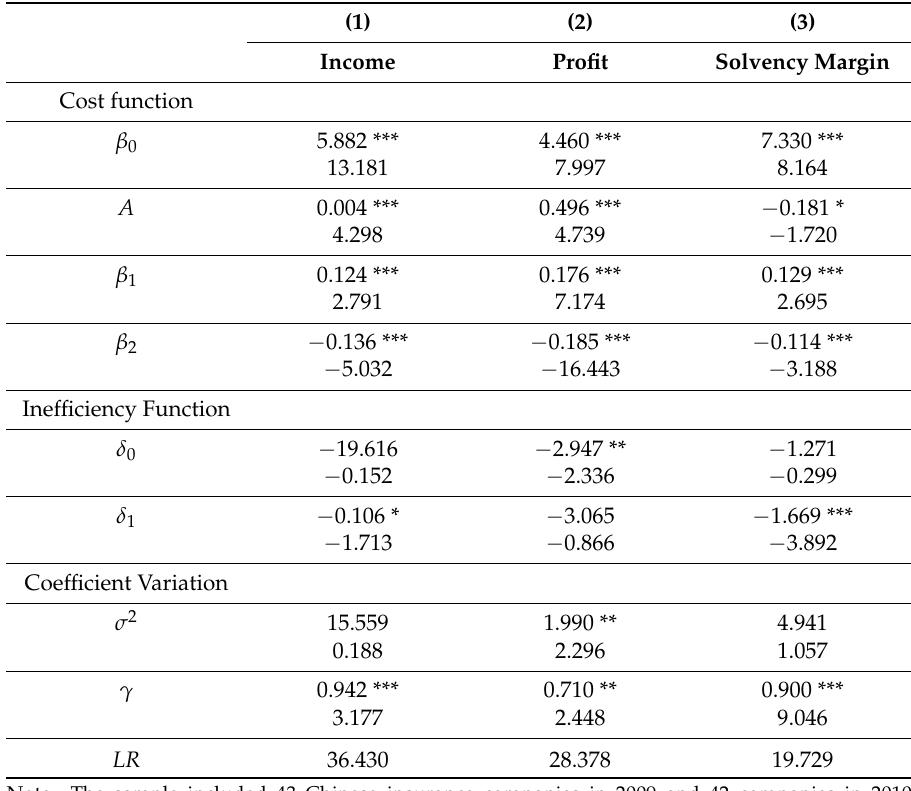
Table 3. The influence of insurance corporate governance on cost